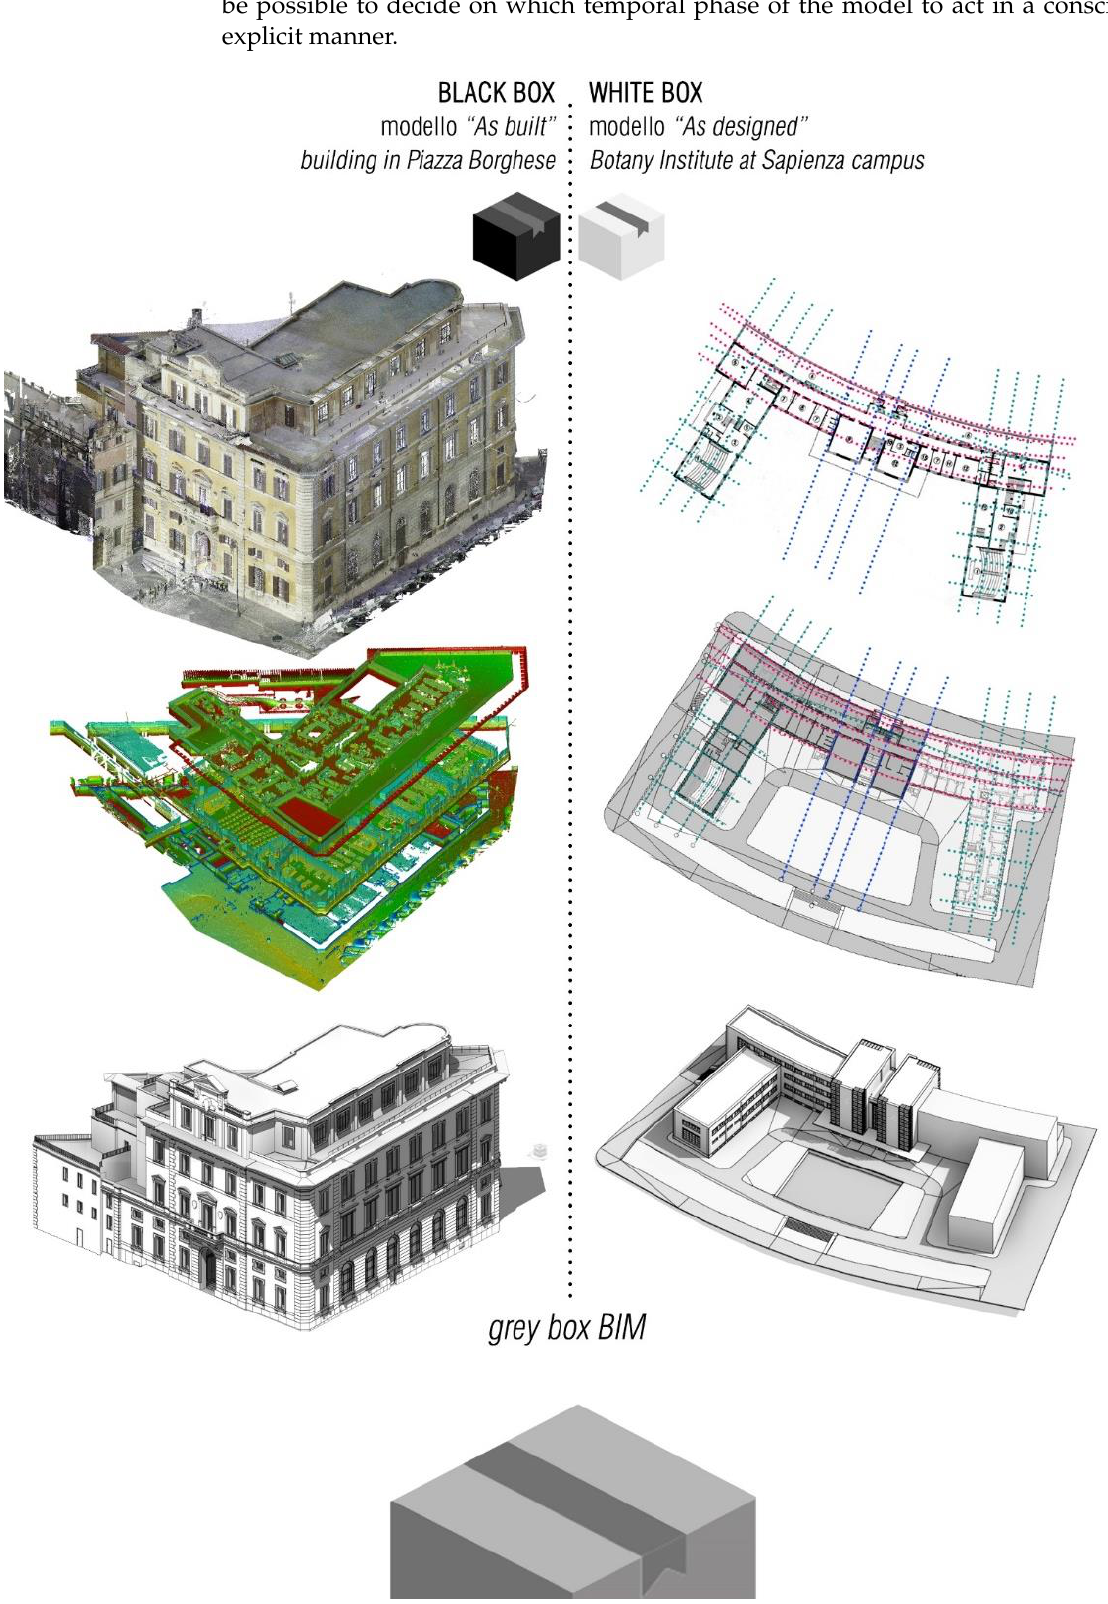
Figure 12. Comparison between “black box” and “white box” model s.